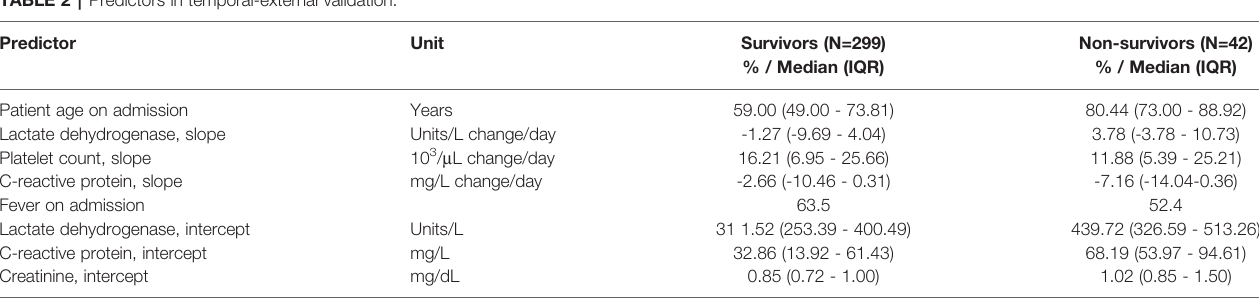
TABLE 2 | Predictors in temporal-external validation.